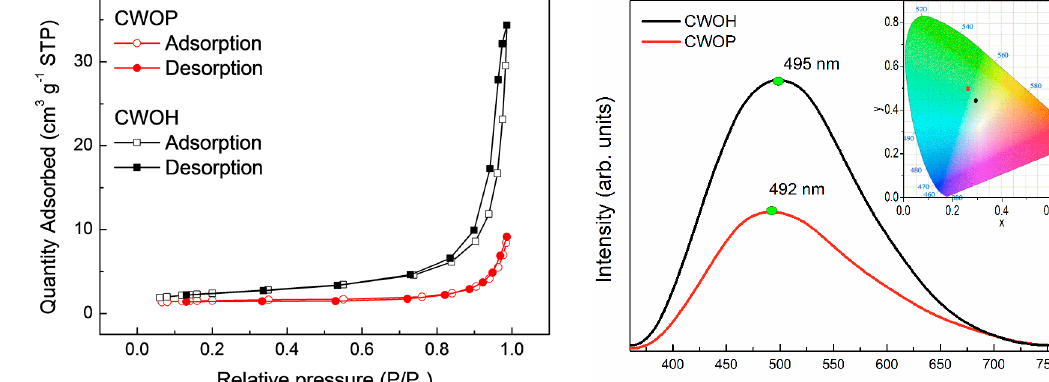
powders (λ = 350 nm). The 4 EXC